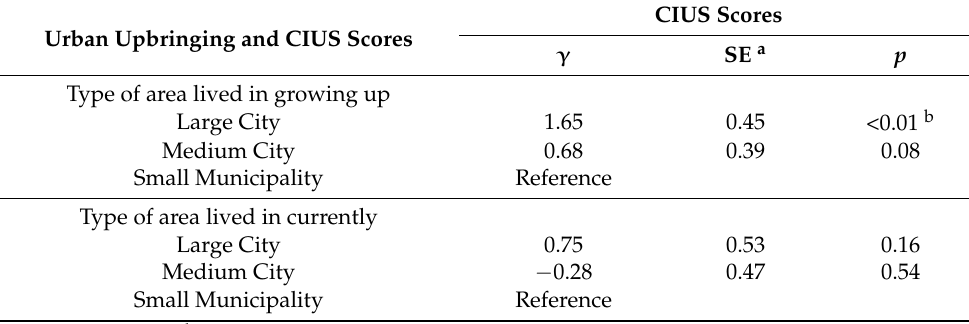
Table 2. Urban upbringing and Compulsive Internet Use Scale (CIUS) scores of adult community residents in Japan: multivariate linear mixed model regression (N =